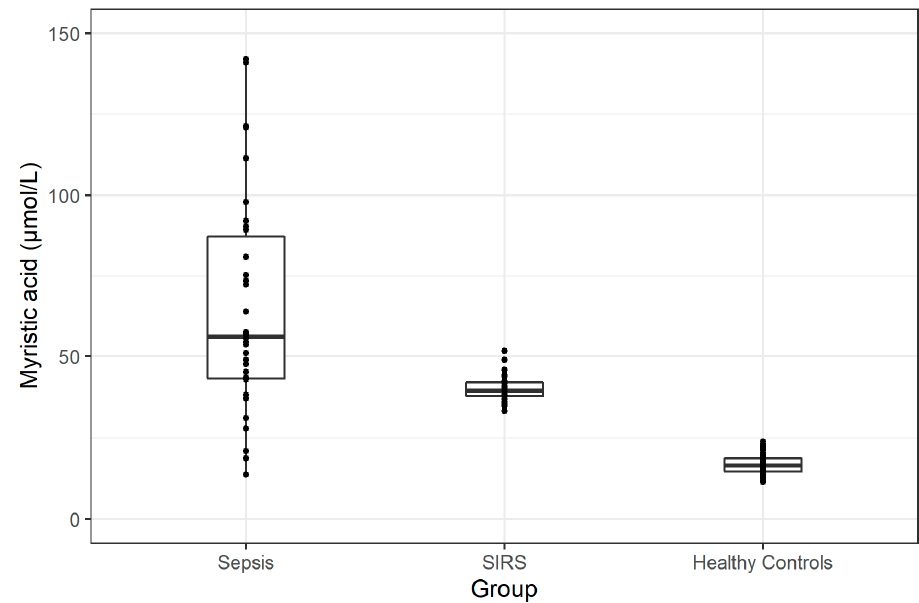
Figure 1. A comparison of peak myristic acid concentrations in the Sepsis, SIRS, and Healthy Control Groups. Comparing the Sepsis and SIRS Groups, the myristic acid levels only differed in the